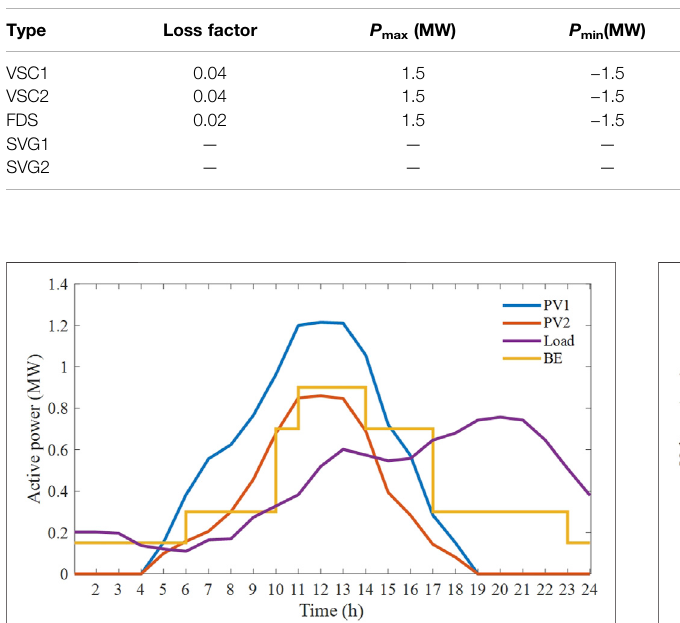
FIGURE 6 | Voltage pro fi les in different cases at 12:00.